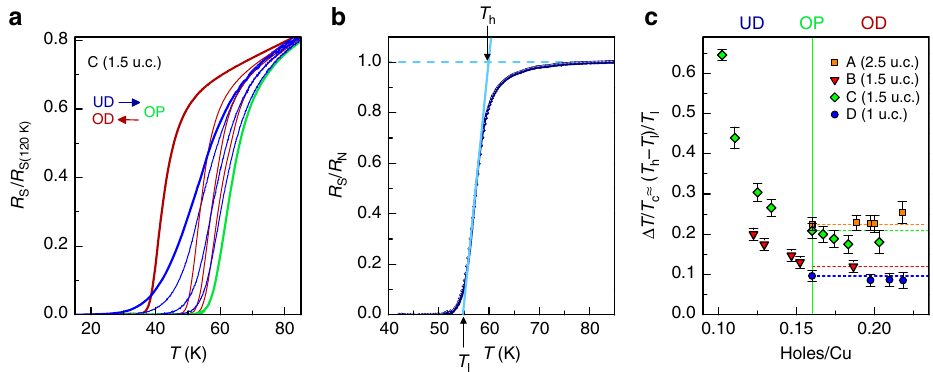
Fig. 5 Transition width dependence on electrostatic doping. a R S ( T ) of device C (1.5 u.c.), normalized to R S (120 K). Thick lines indicate the most underdoped (UD, blue), the optimally doped (OP, green), and the most overdoped (OD, brown) curves. b R S ( T )/ R N ( T ) (with R N ( T ) normal state resistance) in the proximity of the superconducting transition. R N ( T ) is determined as R 0 + BT m or as R 0 + aT − bT 2 according to whether the device is overdoped or underdoped, respectively. A linear component is fi tted to the superconducting transition with T h and T l extrapolated as the intersection with the dashed green line and the x axis, respectively. c Doping dependence of the normalized superconducting transition width Δ T / T c , for varying thickness and disorder. Error bars take into account uncertainty of determination of transition